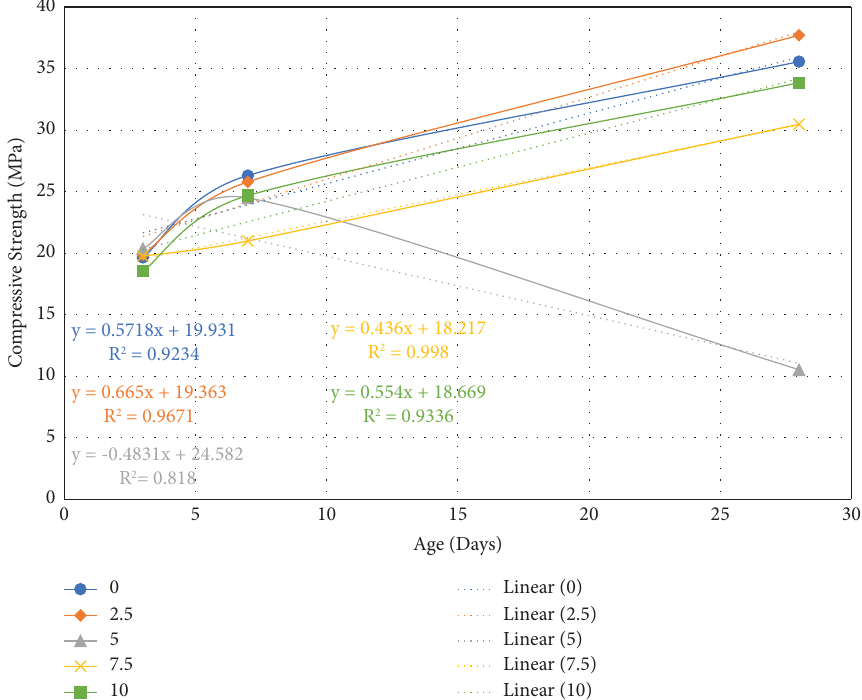
Figure 9: Compressive strength of mortar on the efect of age. Table 2: Chemical composition of POFA (adopted from reference